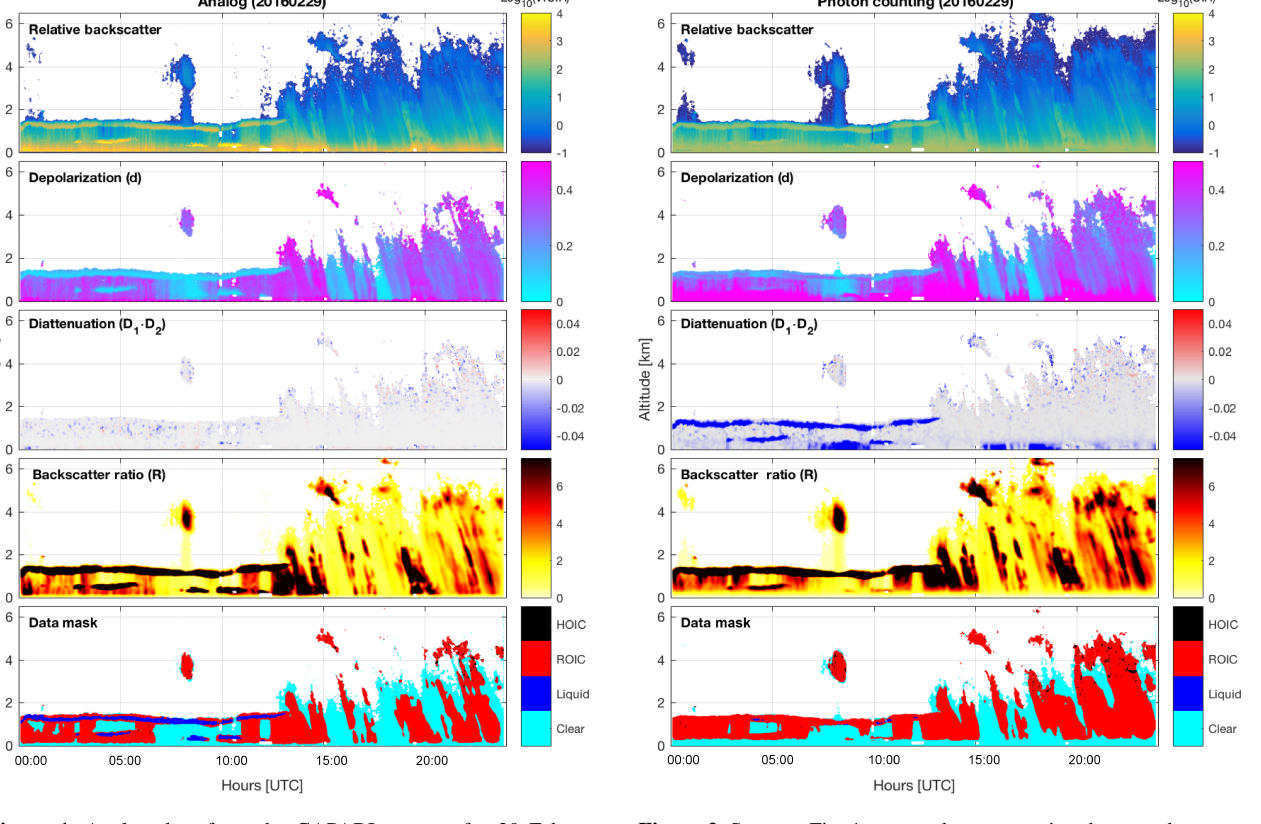
Figure 1. Analog data from the CAPABL system for 29 Febru- ary 2016. Relative backscatter is the summation of background- subtracted parallel and perpendicular voltages converted to a virtual count rate (V.C.R.) in MHz. Depolarization is calculated as given in Eq. (2). Diattenuation is calculated as given in Eq. (3) and multi- plied to D 1 D 2 . Backscatter ratio is calculated by performing a Klett inversion and using ICECAPS radiosonde data (launched at 24:00 and 12:00UTC daily) to calculate a molecular extinction compo- nent (Klett, 1981). The data mask given is calculated using rules described in Sect. 3.